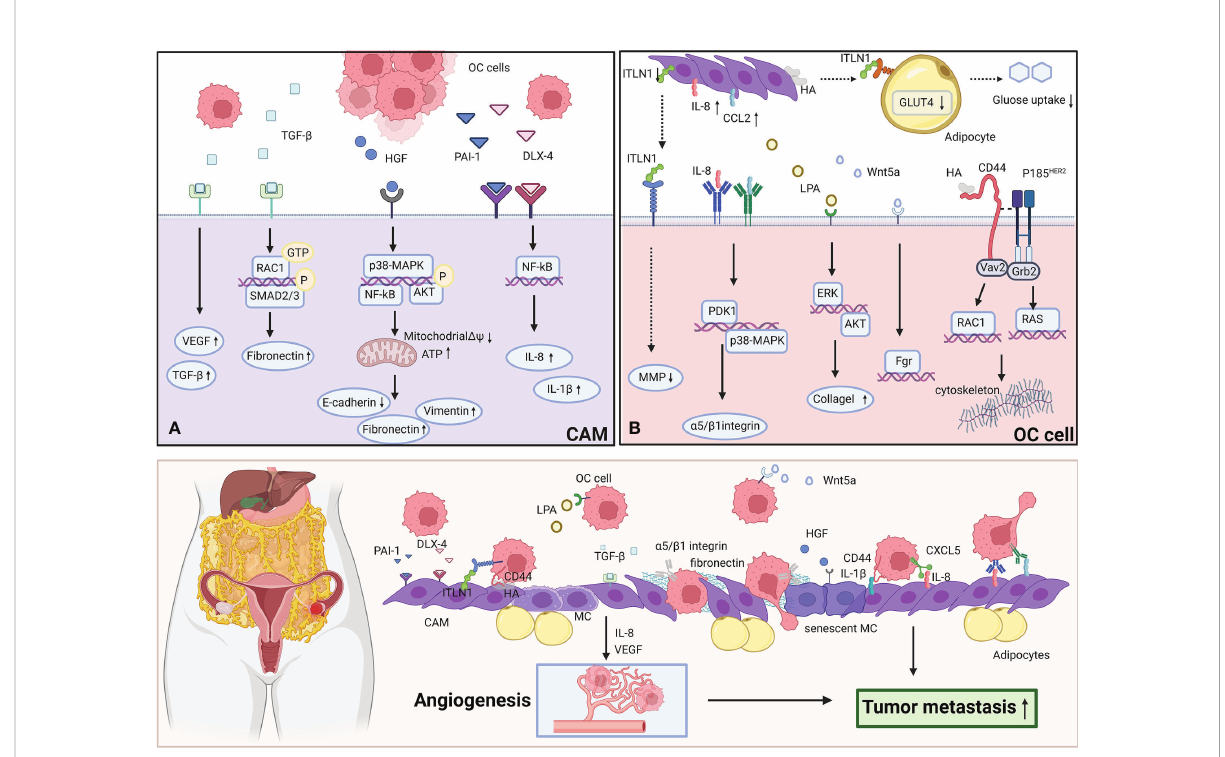
FIGURE 1 CAMs interact with OC cells to promote the metastasis. (A) OC cells secret TGF- b , HGF, PAI-1, DLX-4 to effect CAMs via various signaling pathways. TGF- b activates RAC1/SMAD3 pathway via TGF- b RII to induce CAMs to upregulate fi bronectin expression. HGF promotes the premature senescence of normal mesothelial cells by inducing mitochondrial oxidative stress via activating several signaling pathways including p38-MAPK, AKT and NF- k B. PAI-1 and DLX4 induce the expression of IL-8/CXCL5 and IL-1 b /CD44 via activating NF- k B signaling. (B) CAMs overexpress ITLN1, IL-8, CCL2, LPA, Wnt5a and HA to effect OC cells by activating several signaling pathways. IL-8 induces the overexpression of PDK1 in OC cells via CXCR1.PDK1 upregulates the expression of a 5 and b 1 integrin to enhance the adhesion to fi bronectin and mesothelial cells. CCL2 facilitates the trans-mesothelial migration and invasion of OC cells via activating p38-MAPK pathway through CCR2. Wnt5a boosts the metastasis of OC cells via activating its downstream effector Src family kinase Fgr. LPA activates ERK and Akt pathway to boost OC cells